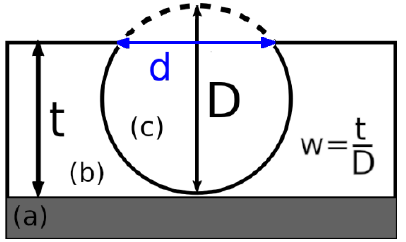
Figure 3. Scheme of the Ag inverse opal ((a) conductive plate (e.g., Ag/ITO/glass), (b) silver layer with the thickness t , (c) spherical void with diameter D , d — diameter of the holes that was measured on the SEM images).